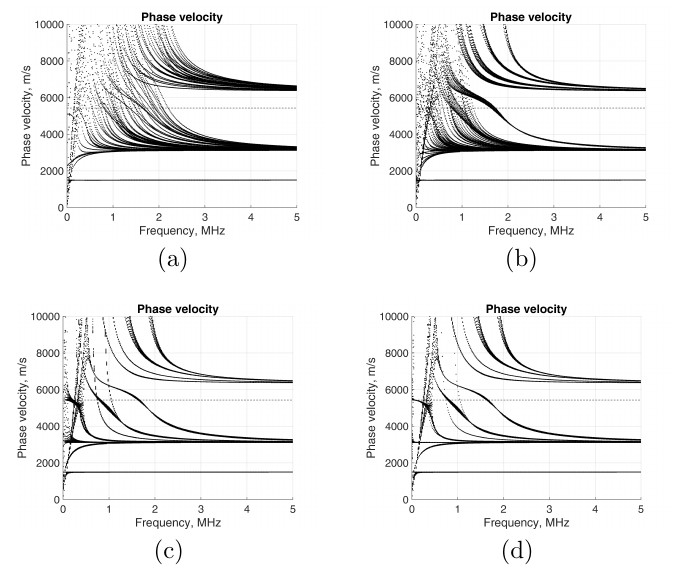
Figure 7. The convergence of the model for cases (a) mesh 3 × 6 and cross-section size ratio 1 : 2, (b) mesh 3 × 10 and cross-section size ratio 1 : 10, (c) mesh 3 × 15 and cross-section size ratio 1 : 100, (d) mesh 3 × 15 and cross-section size ratio 1 :